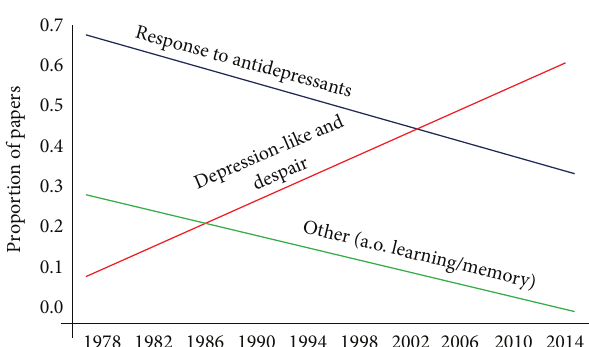
Figure 1: The figure shows the interpretation of the outcomes of the FST as a function of year of publication. The slopes that are plotted indicate that over the years more studies choose to label the outcomes from the FST as “depression-like behaviour” (the red line) and fewer as “antidepressant” properties of drugs (the blue line) or behavior such as “learned immobility” (the green line). For more information on these data we refer to Molendijk and de Kloet